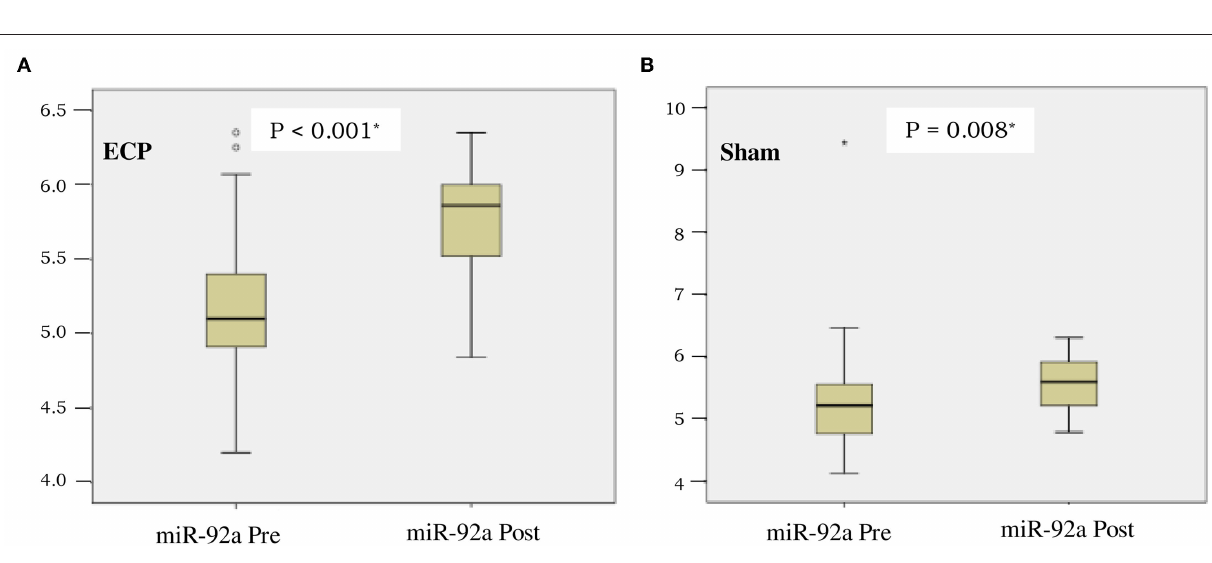
ECP group [-517 pg/ml ( − 1,549 to + 1,407) vs. − 171 ( − 844 to + 1,166); consecutively, P = 0.021]. A negative mark denoted